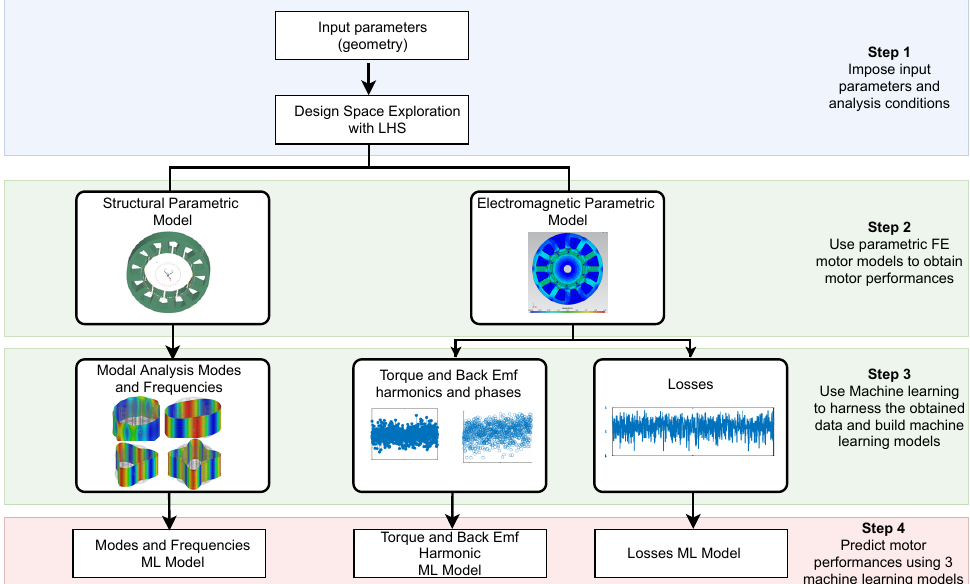
Figure 1. Multi-attribute machine learning model workflow.